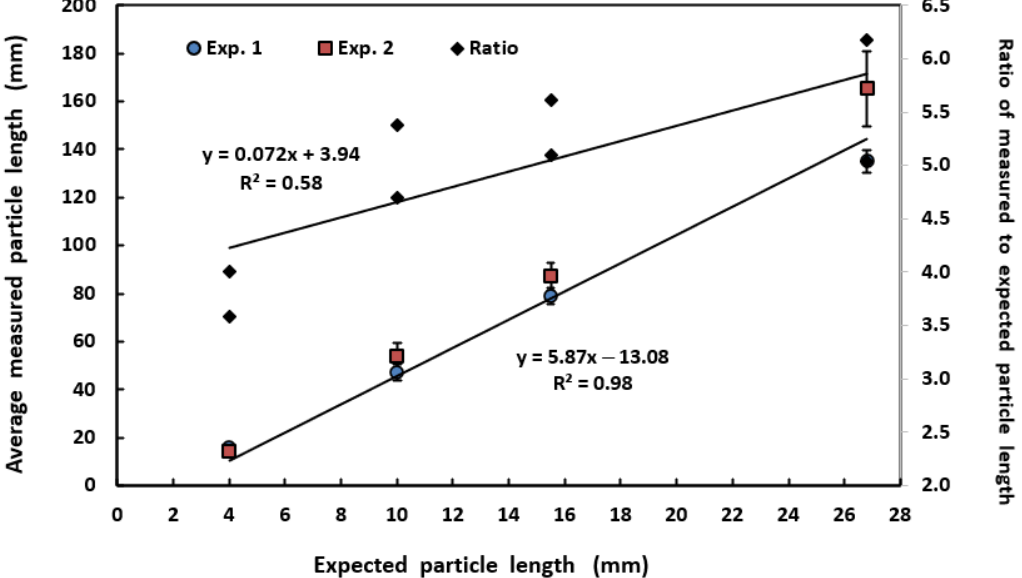
Figure 7. Particle length of hand measured particles and over-screening ratio versus expected particle length (based on Equation (2)) for Experiments 1 and 2. Error bars represent standard error of the mean.